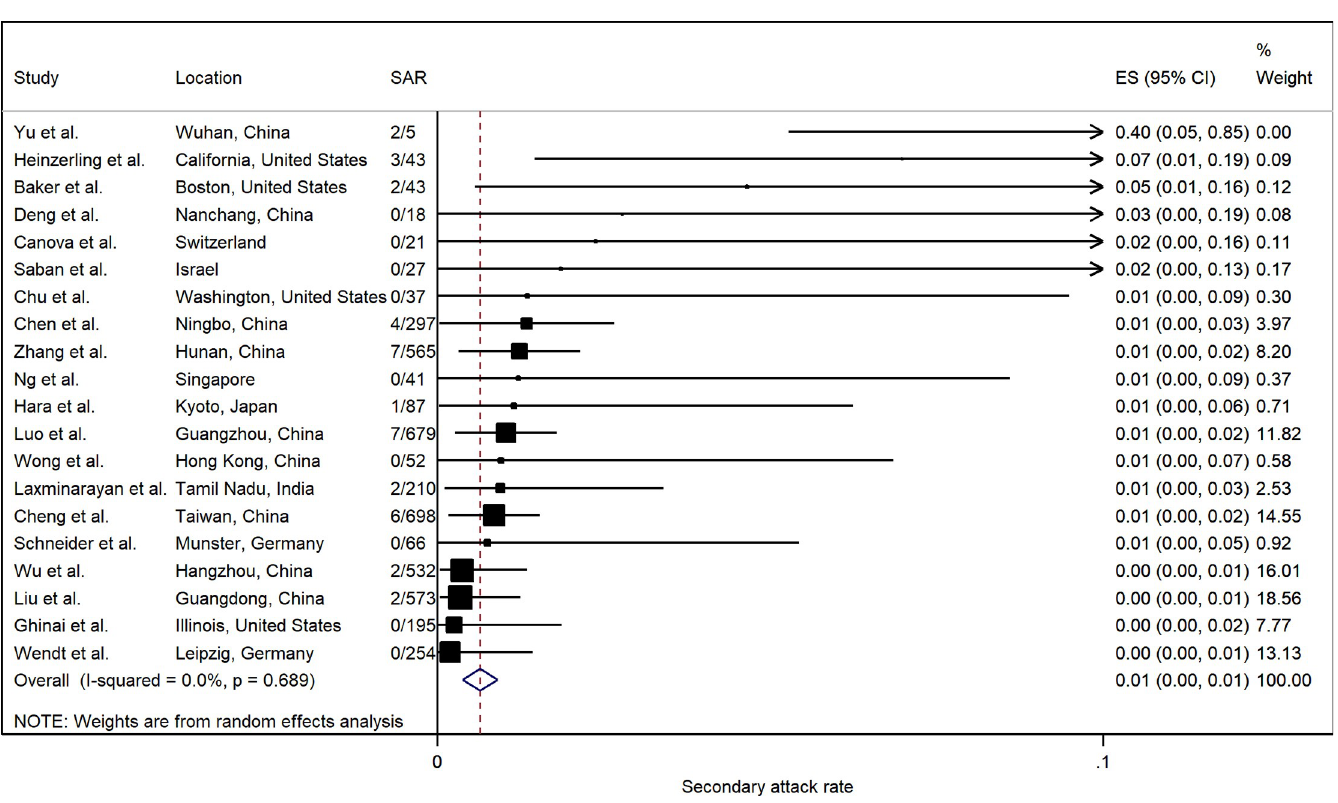
Fig 9. Forest plot of secondary attack rates (SAR) in healthcare settings. ES is the estimated SAR, with 95% confidence intervals (CI). I-squared is the percentage of between-study heterogeneity that is attributable to variability in the true effect, rather than sampling variation.